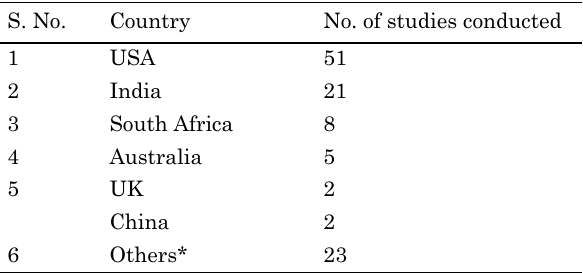
Table 1. Country-wise publication of studies on EVA (Sharma, Kumar